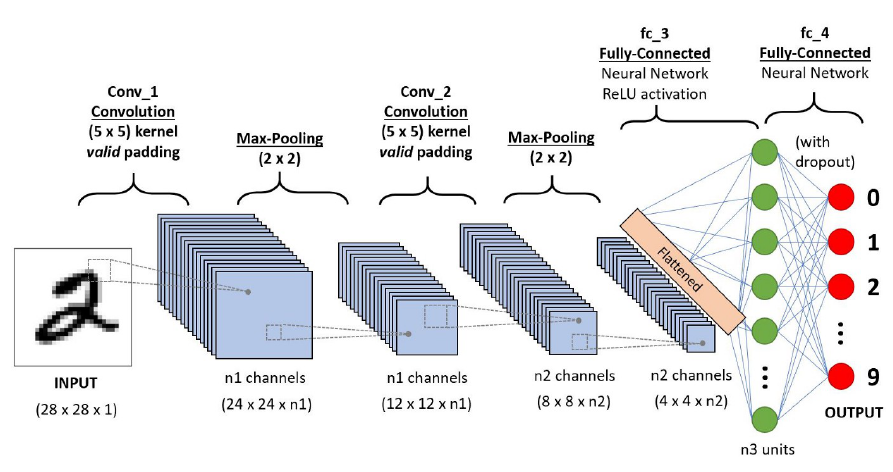
Figure 2. Performance comparison of the proposed framework and Medrec.